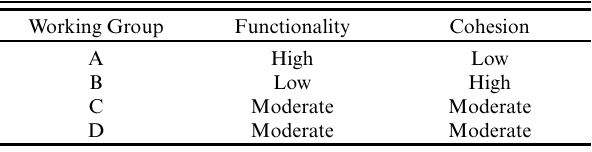
Table 2 . Comparison of working group functionality and cohesion.